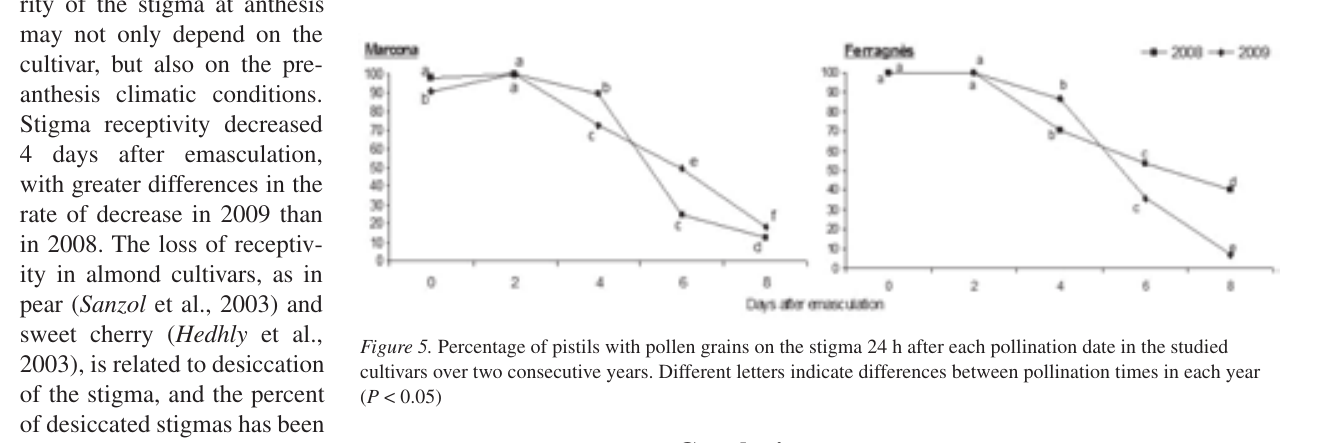
Figure 4. Maximum, minimum and mean daily air temperatures during blooming of ‘Marcona’ and ‘Ferragnès’ in 2008 and 2009 at the experimental site